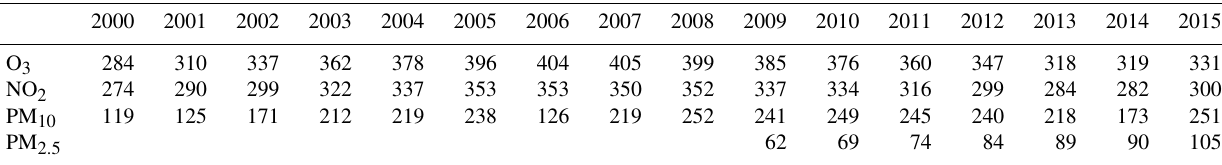
Table 1. Number of background French monitoring sites for the years 2000 to 2015.